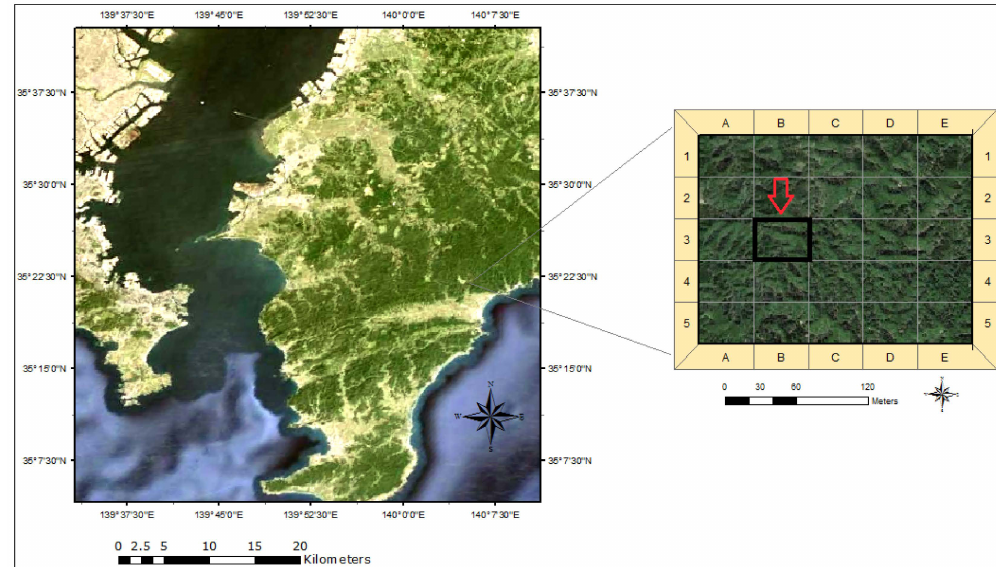
Figure 1. Location of the research area in Chiba Prefecture, Japan (source Google Earth, detail image partially modified for enhanced brightness).